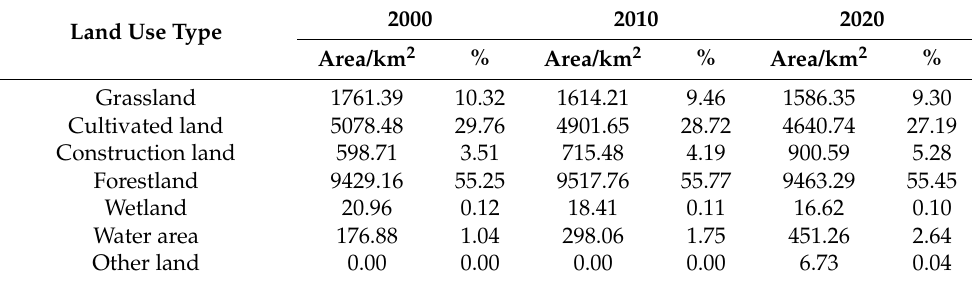
Table 4. Changes of land use structure.